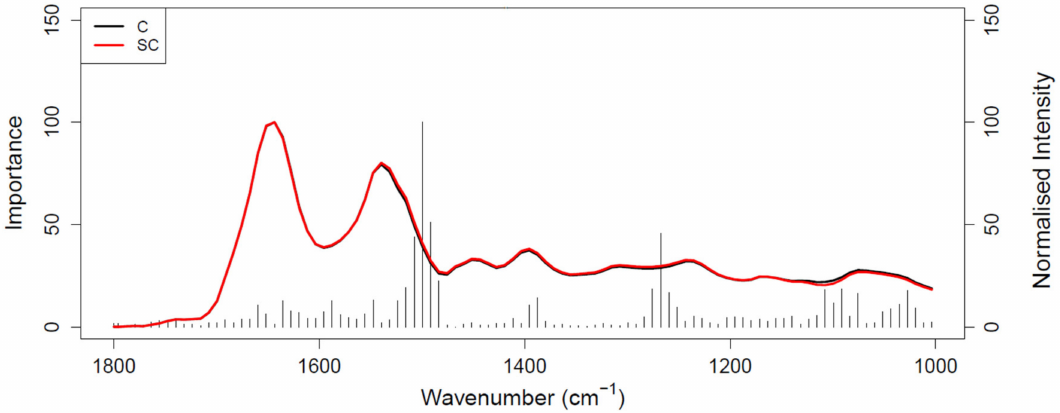
Figure 5. Gini importance plot of RF analysis performed on Cohort B; C (black) represents the pancreatic cancer spectrum and SC (red) represents the symptomatic control spectrum.